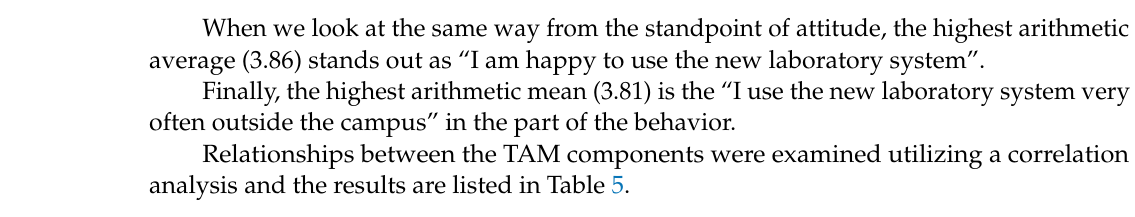
Table 5. Correlation analysis